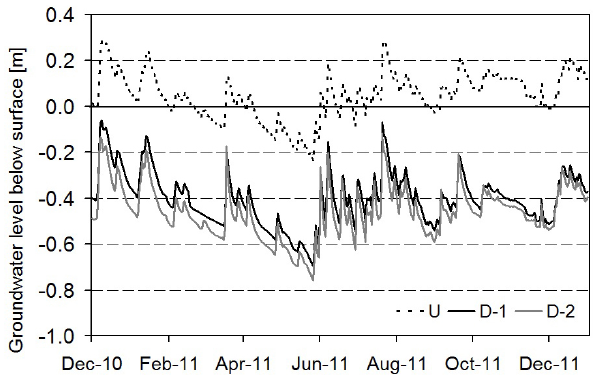
Figure 1. Annual variation in the groundwater level (U = undrained; D-1 = drained site 1; D-2 = drained site 2). Please note that the x axis starts on 1 December